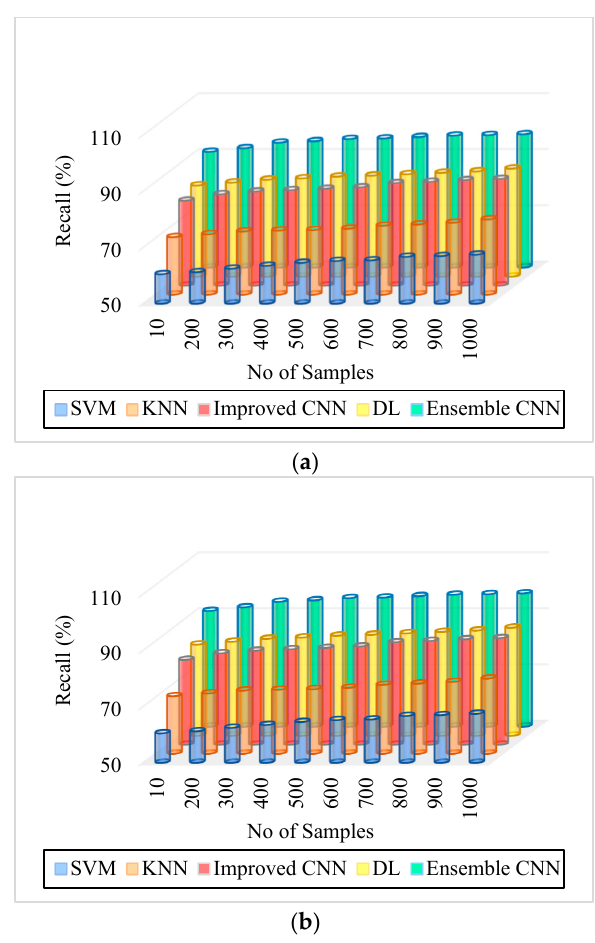
Figure 7. Recall. ( a ) IDRiR and ( b ) Messidor.